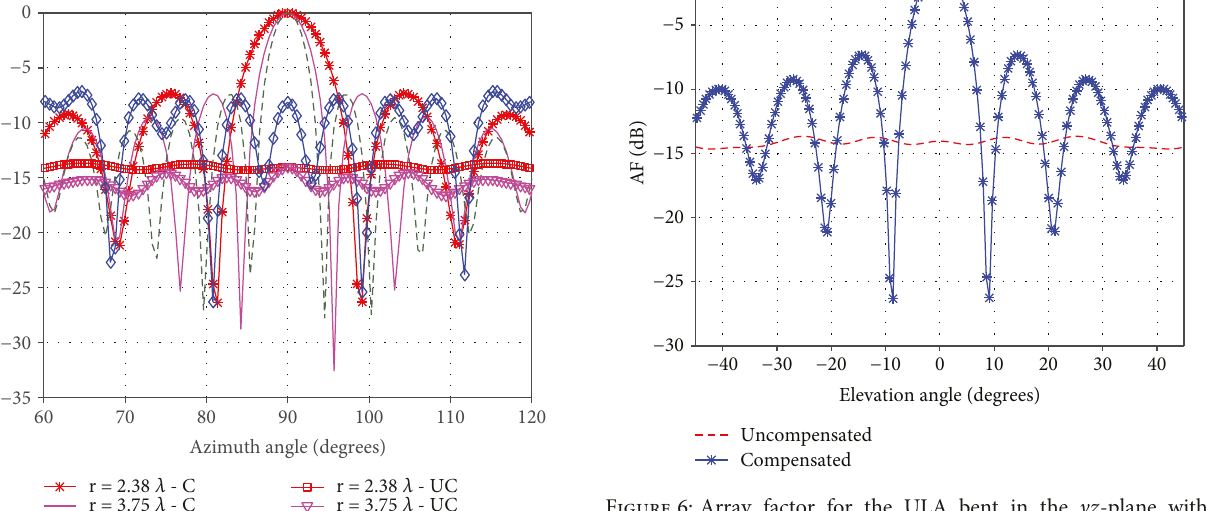
Figure 6: Array factor for the ULA bent in the yz -plane with r = 2 38 λ .